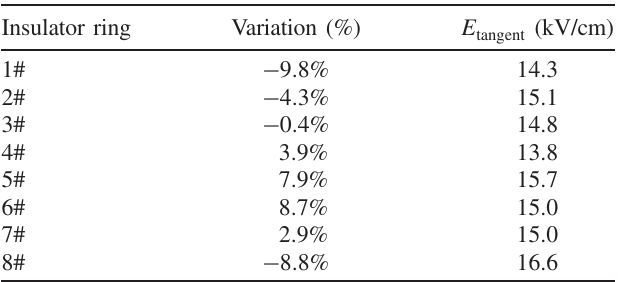
TABLE I. Potential grading variations from the uniform dis- tribution and the electric fields tangent to the insulator rings at the cathode triple junctions for each insulator ring.